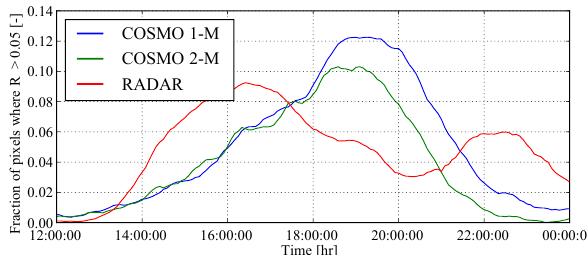
Figure 11. Fraction of wet area during the event of the 13 August